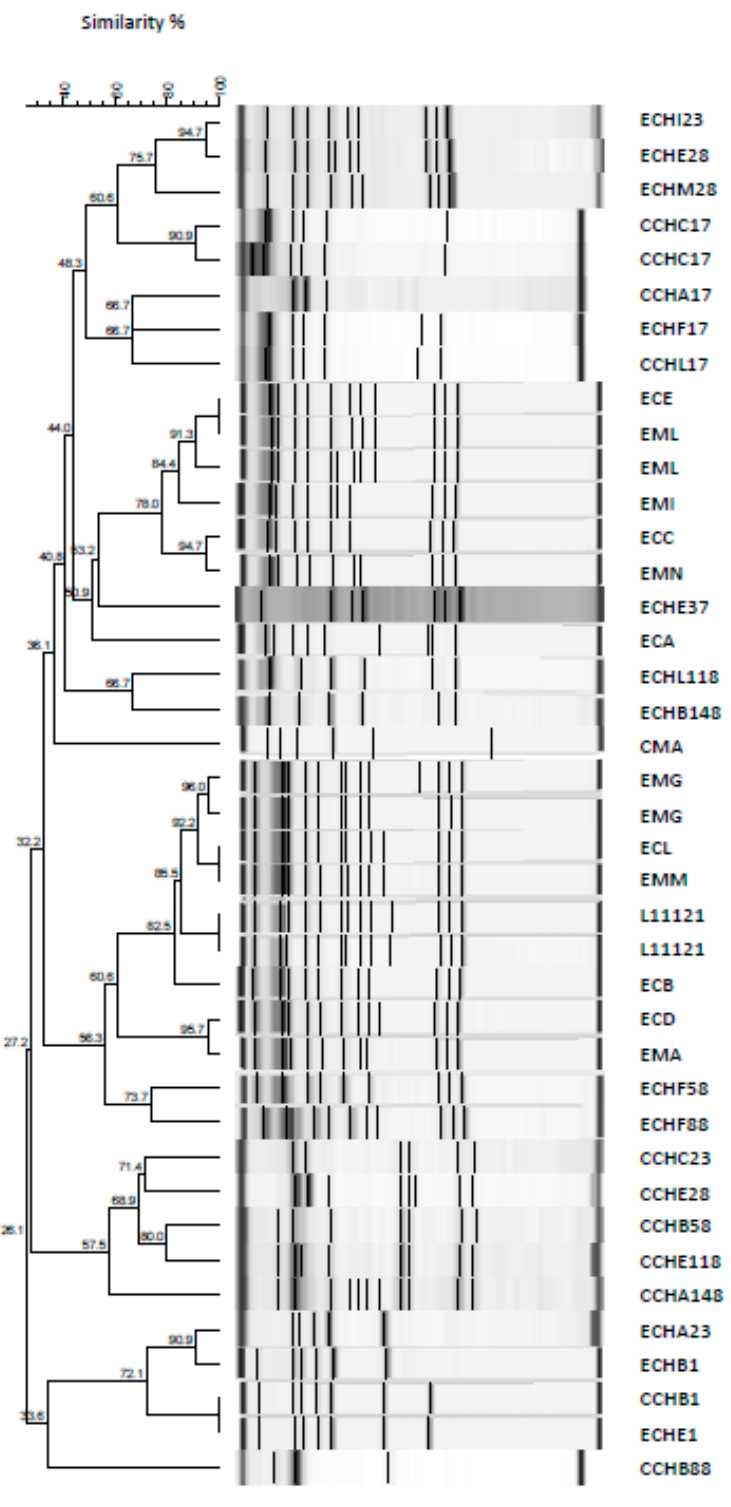
Figure 3. Clustering of Rep PCR profiles for L. paracasei isolates from the cheese production trial for cheese with (E) or without (C) addition of L. paracasei L11121. The isolate labels indicate the cheese batch of origin (E or C); the sample type, i.e. milk (M), curd (C) or cheese (CH); isolate identity, defined with a letter; and the day of isolation.